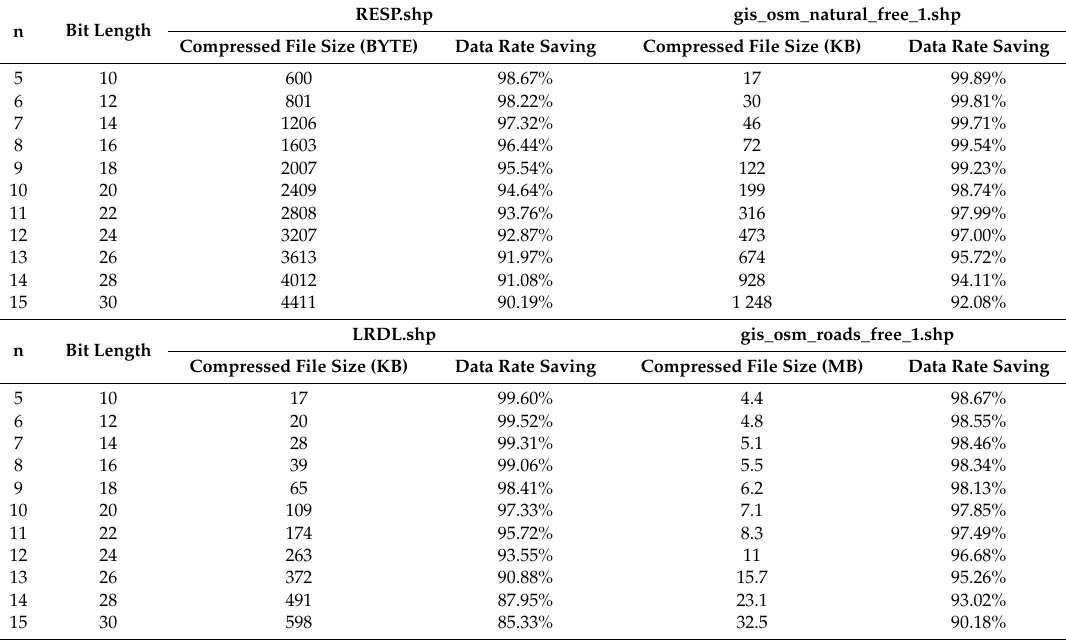
Table 5. Compression saving table at different space division n.